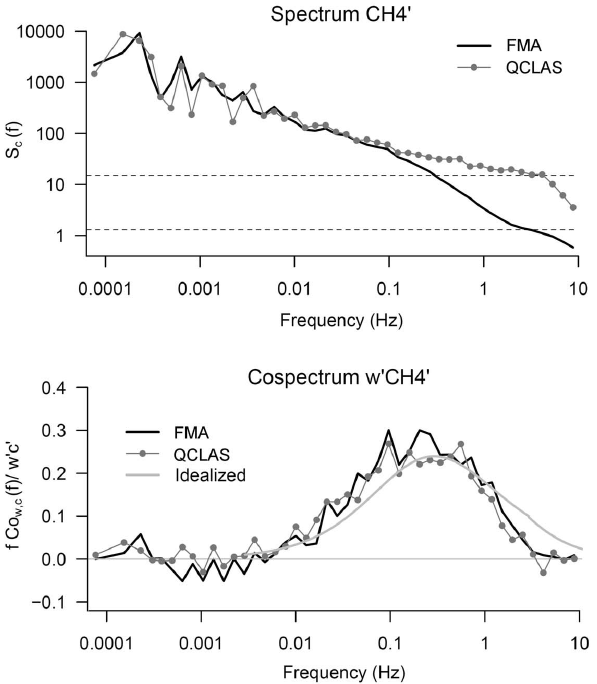
Fig. 6. Comparison of spectra and cospectra during high flux condi- tions (102nmolCH 4 m − 2 s − 1 , 31 March 2009, 11:00–14:38CEST (218 records) with u = 3 . 86ms − 1 ). The gray line shows the ide- alized cospectrum for neutral and unstable conditions according to Kaimal et al.